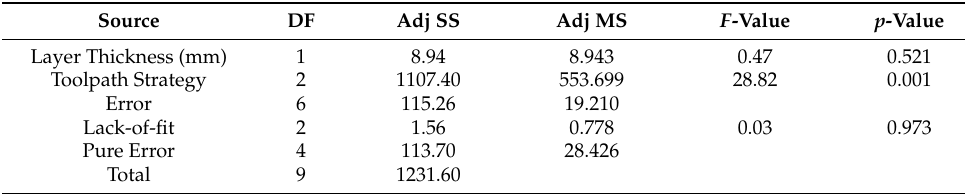
Table 4. ANOVA Analysis on the Layer Thickness and Toolpath